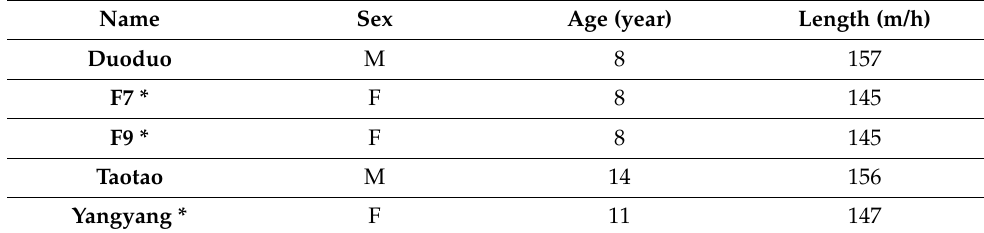
Table 1. Catalog of studied individuals’